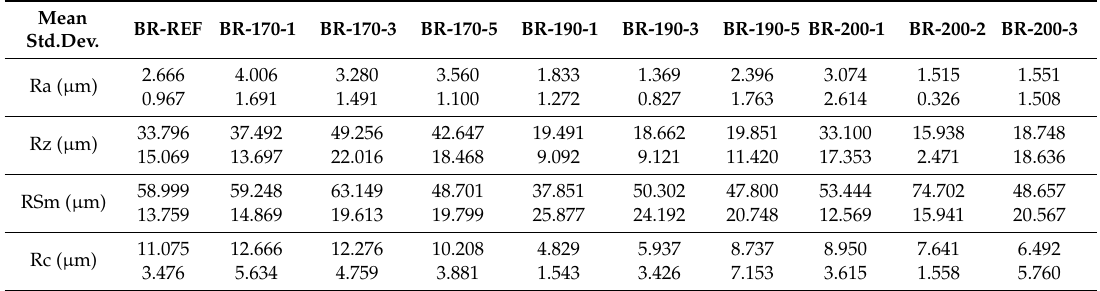
Table 1. The basic statistical analyses of the roughness parameters determined by the optical method. Mean Std.Dev.